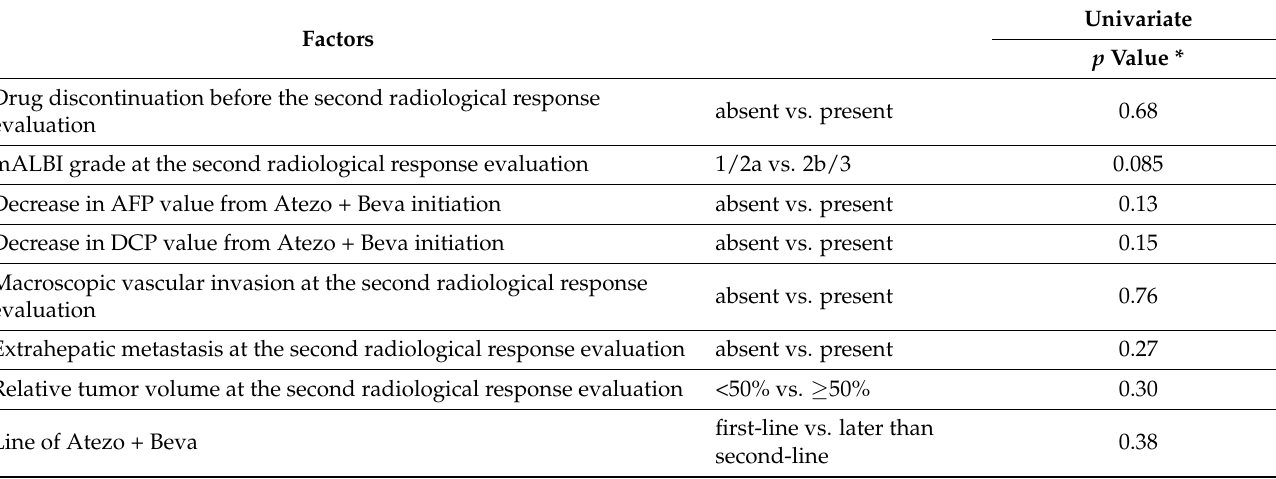
Table 5. Univariate and multivariate analyses of prognostic factors for overall survival from ate- zolizumab plus bevacizumab combination therapy initiation in 59 patients with SD at the second radiological response evaluation by Response Evaluation Criteria in Solid Tumors.